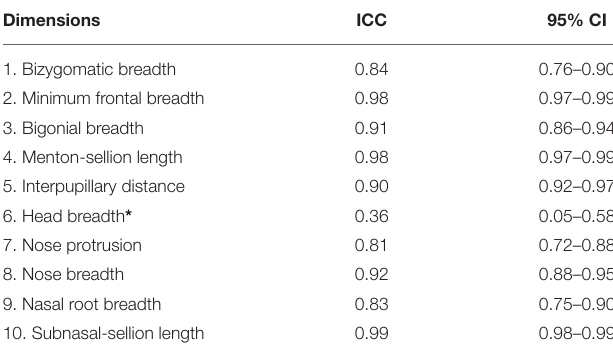
TABLE 4 | Reliability coefficient between direct measurement and 2D